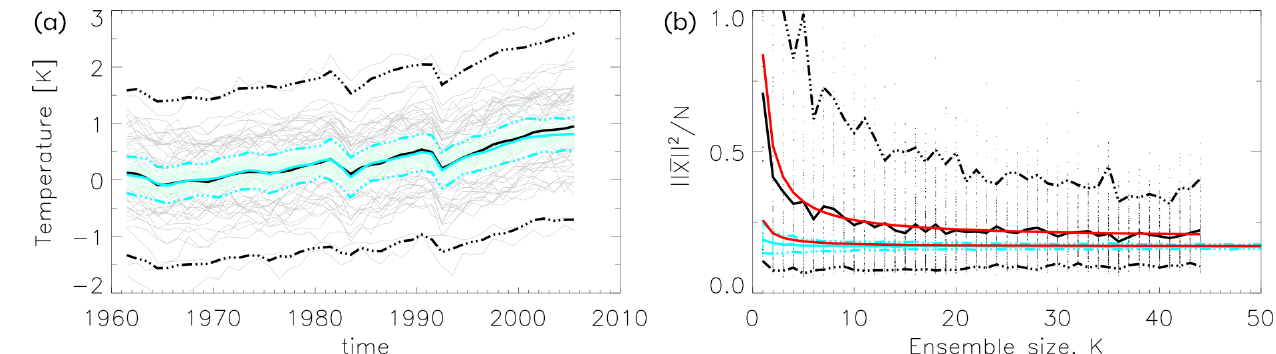
Figure 9. (a) Time series of annual NH mean temperature from MPI-GE (black) and CMIP5 (cyan). Thick solid curves are ensemble means, a dashed curves ensemble means ± 2 standard deviations, and thin curves are individual models. Each ensemble has been centred to its ensemble mean in the first 10 years. (b) The length of the ensemble mean || x || 2 /N as a function of ensemble size K for MPI-GE (black) and CMIP5 (cyan). The ensemble means ± 2 standard deviations are also shown. Theoretical results from Eq. (12) with σ 2 = 0 . 094, µ 2 = 0 . 164 K 2 for MPI-GE and σ 2 = 0 . 654, µ 2 = 0 . 193 K 2 for CMIP5 are shown in